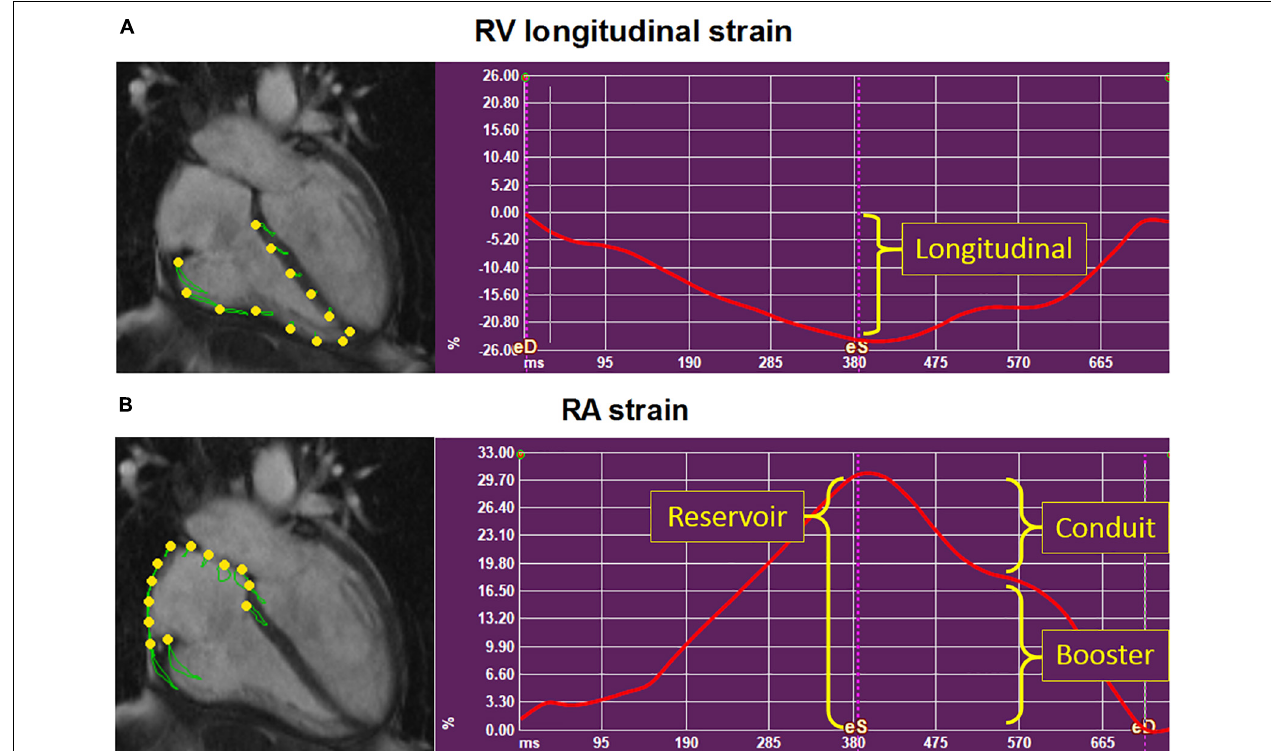
FIGURE 1 | Depiction of the right ventricular and right atrial strain parameters. Example of the strain parameters ( y -axis, %) in time ( x -axis, ms) in a systemic sclerosis patient, using Medis Qstrain software. Right ventricular (RV) longitudinal strain (A) and right atrial (RA) strain (B) were measured on the long-axis 4-chamber cine images. (B) RA reservoir strain measures RA filling of blood from the central venous return during RV systole. RA conduit strain measures the passive emptying of blood from the RA into the RV. RA booster strain measures the active filling of blood from the RA to the RV: The RA contraction. RA, right atrial; RV, right ventricular.